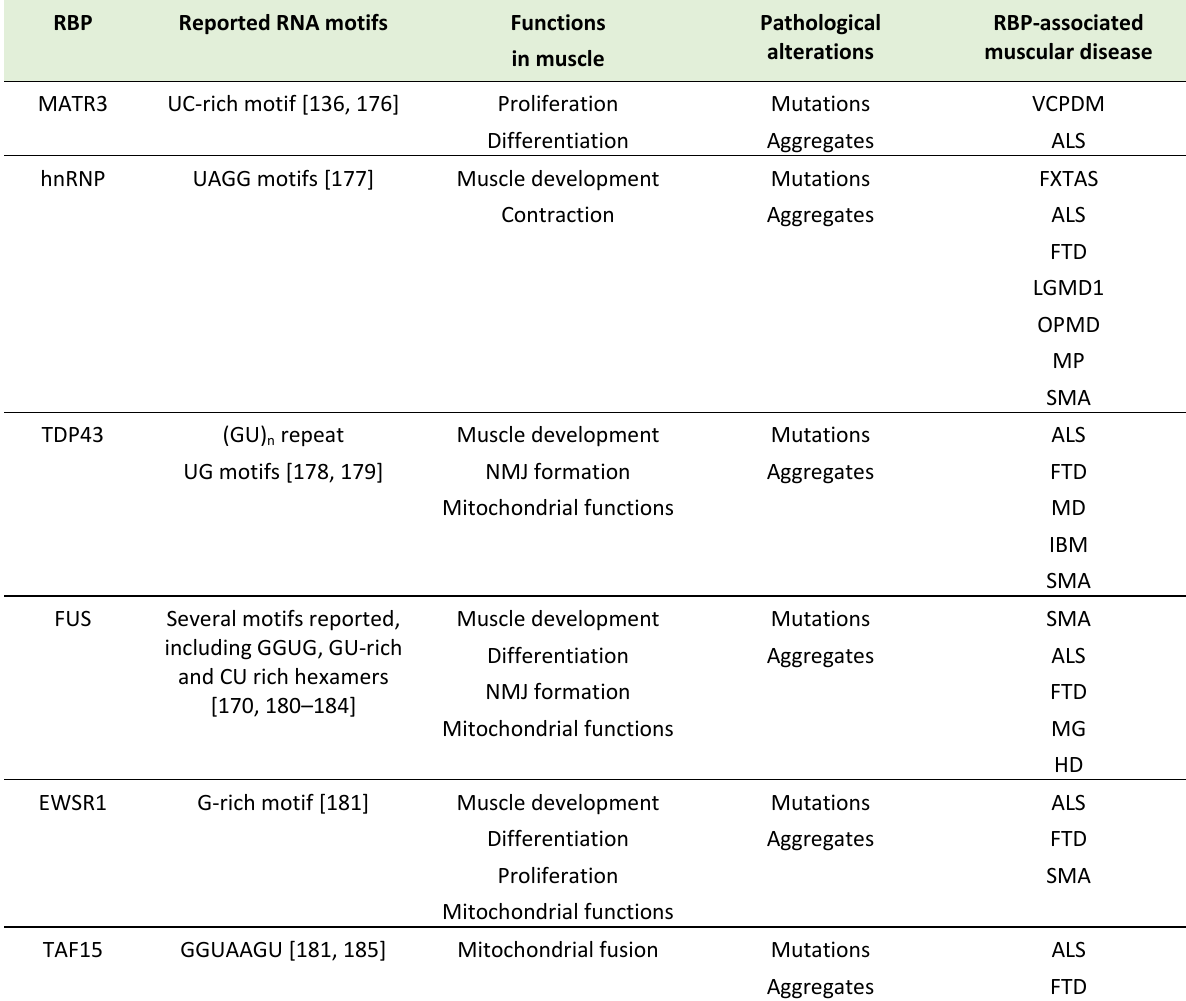
TABLE 1. Summary of selected RBP with prion like domain in neuromuscular